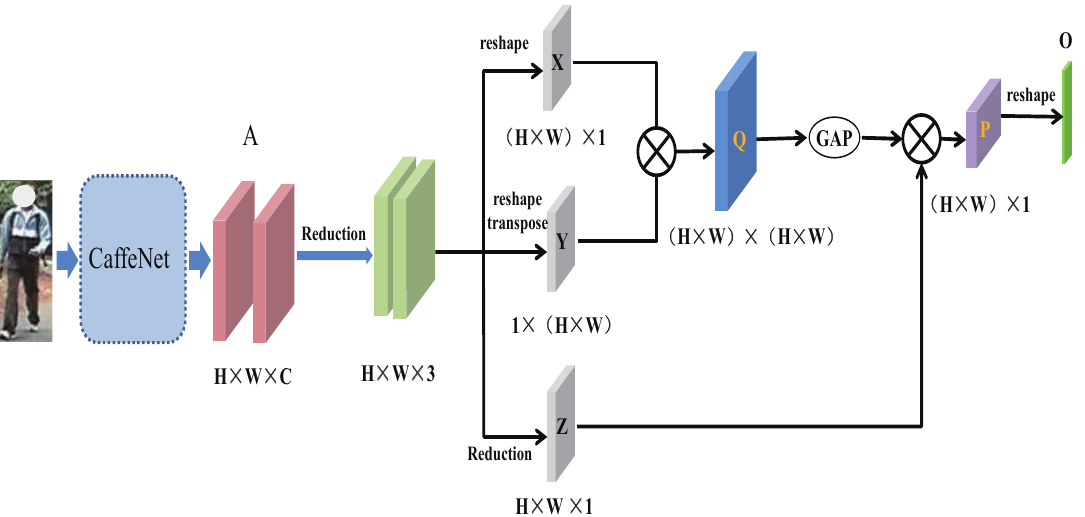
Figure 5. The color attribute network reduces the extracted convolutional feature map A ∈ R H × W × C into H × W × 3 correspondingly. Then, the three channels feature map is divided into X , Y , and Z for the global average pooling operation,